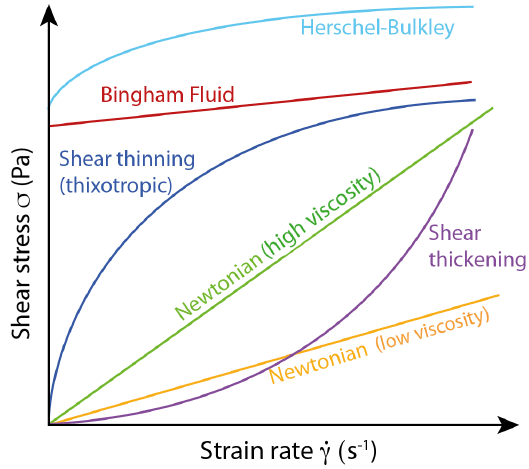
Figure 5. Flow curves of different fluid rheologies, depending on shear stress and strain